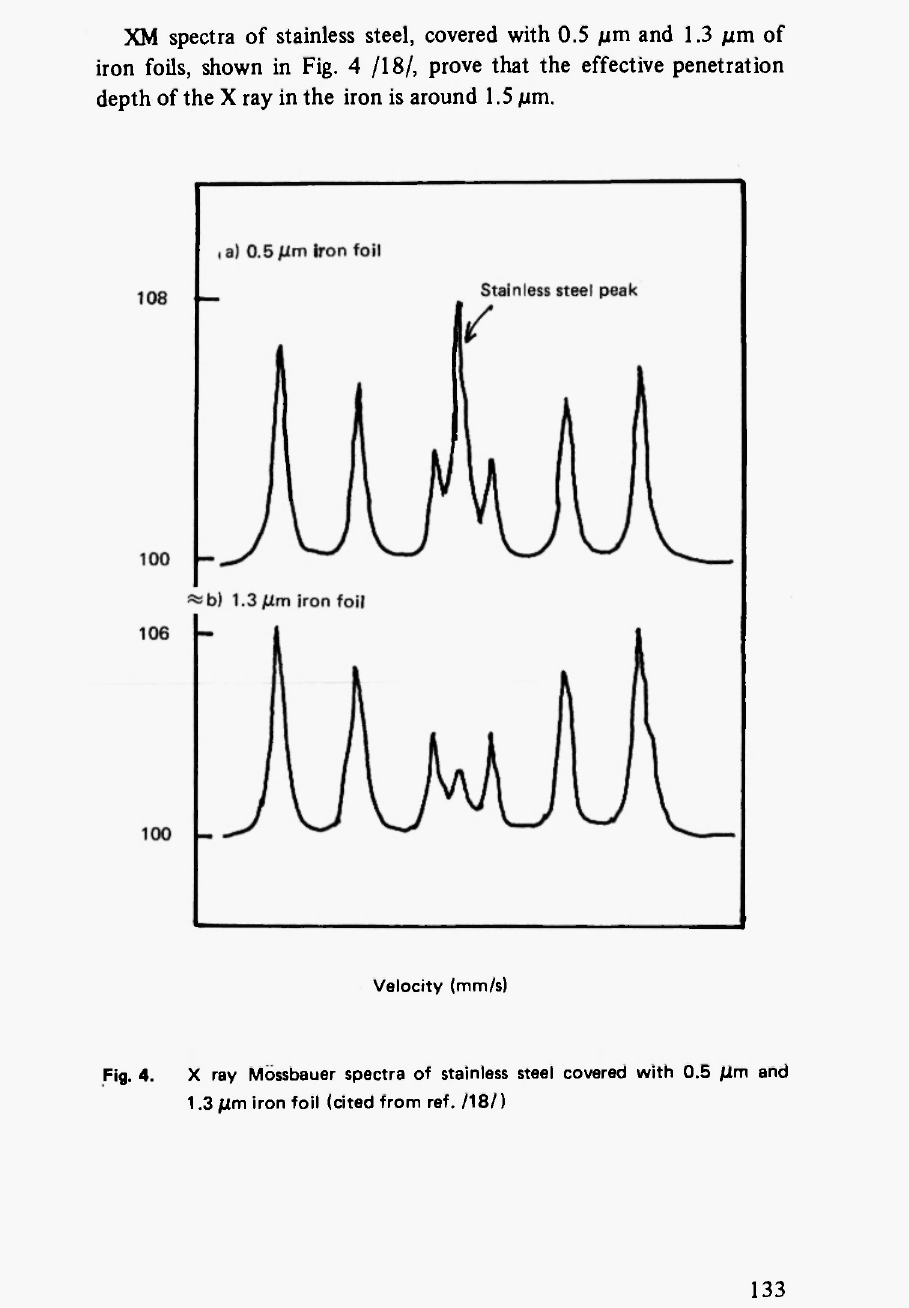
X ray Mossbauer spectra of stainless steel covered with 0.5 fJ.m and 1.3 μηη iron foil (cited from ref. /18/)